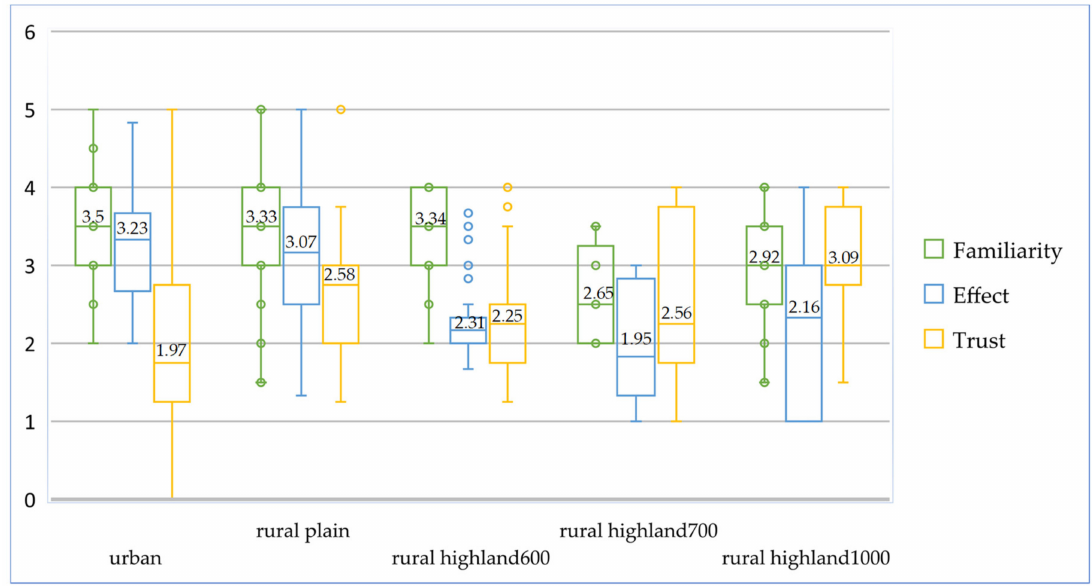
Figure 2. Mean values of risk perception